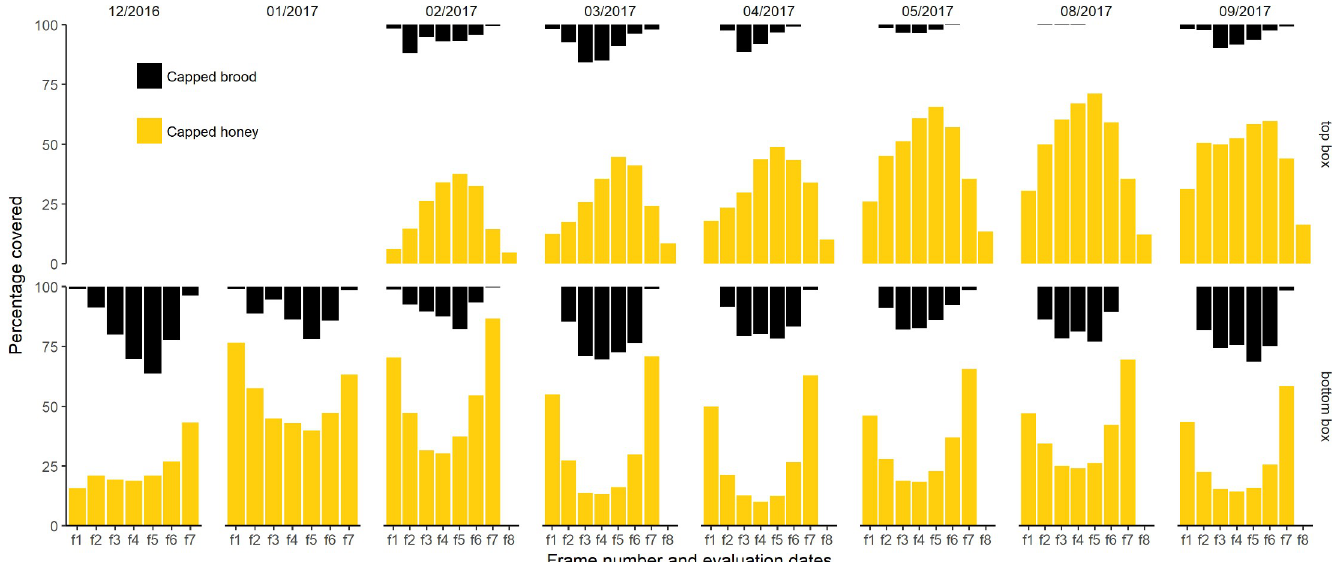
Fig 6. Average value of the amount of capped honey (yellow) and capped brood (grey) for each frame of the 16 hives included in this study at 8 different evaluations. A top box was added in January 2017. The 8 th frame of each bottom box was replaced by a frame feeder used during colony establishment and left in the hives. Hives were left undisturbed during Winter (between May 2017 and August 2017). Capped honey and capped brood are represented separately in S2 and S3 Figs.